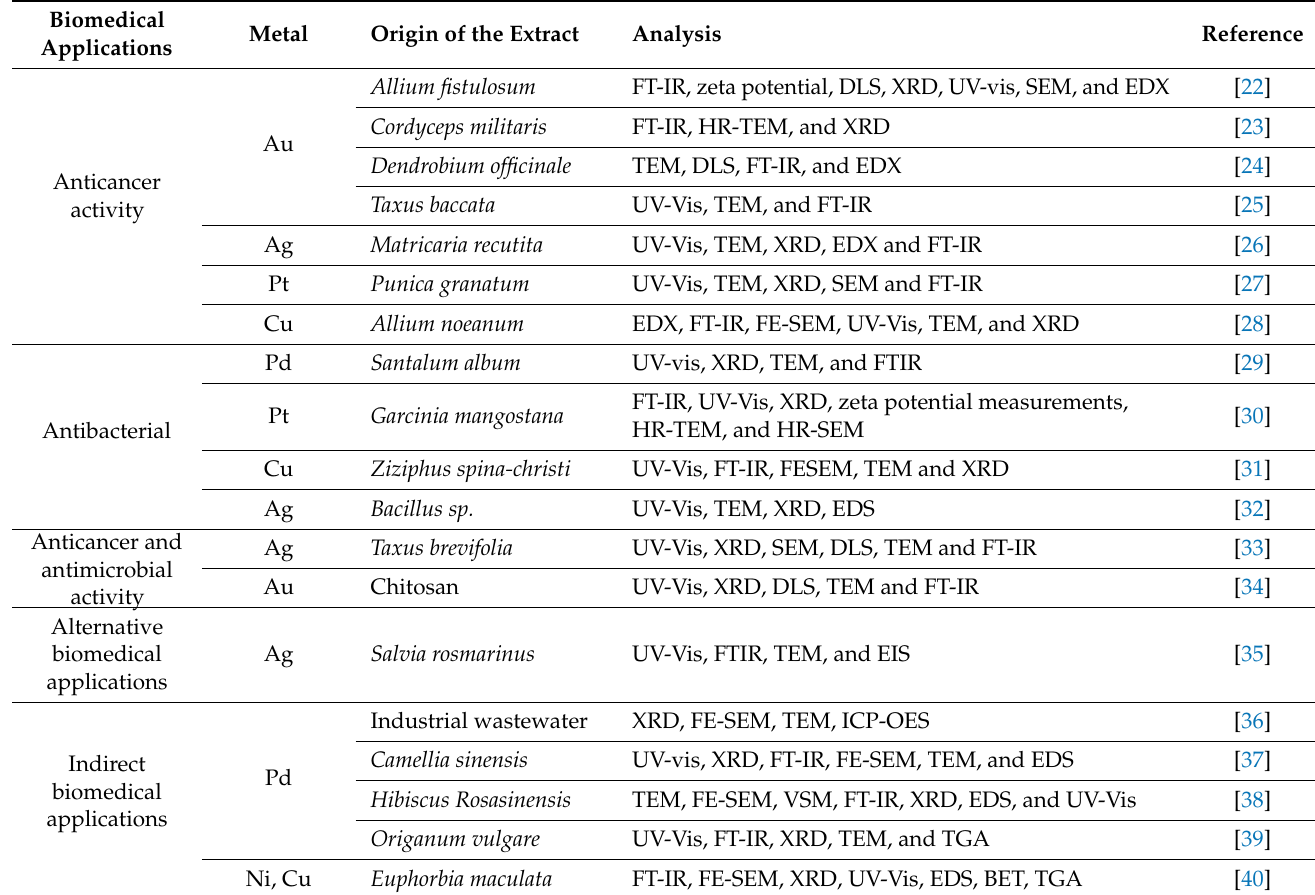
Table 1. Summary of analysis of selected biosynthesized nanoparticles.